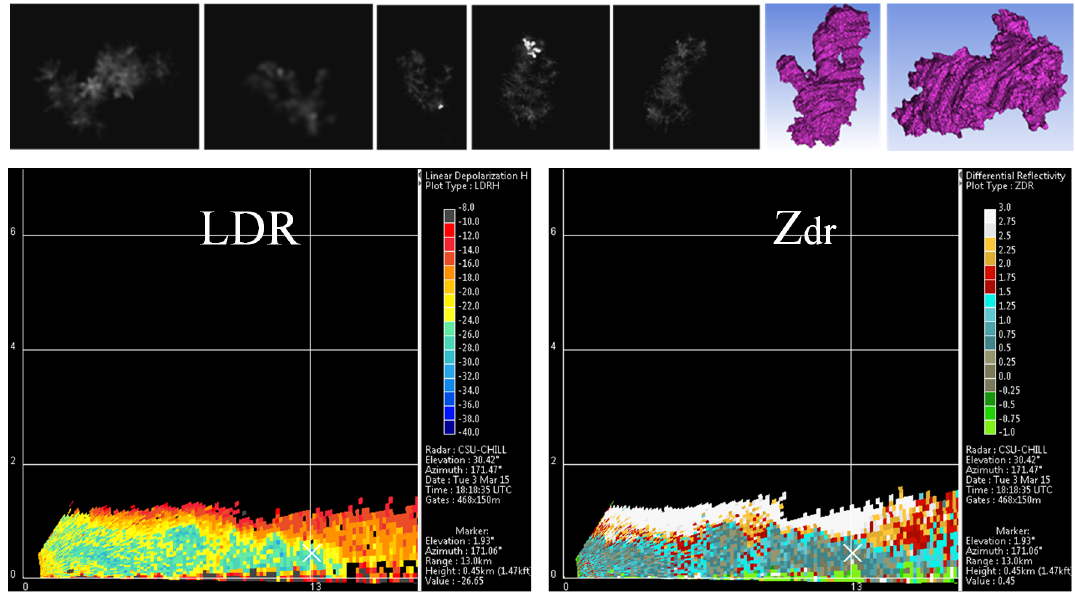
Figure 37. Illustrative results of MoM-SIE scattering calculations based on the MASC images captured at the MASCRAD Field Site during the positive Z dr in dissipating light snow area event on 3 March 2015 and the resulting 3D shape reconstruction, in comparison with the corresponding LDR and Z dr data observed simultaneously by the CSU-CHILL radar. Results: MASC/MoM-SIE: ε r = 1.153 − j0.0002, LDR = − 36 dB, Z dr = 0.28 dB; CHILL Radar: LDR = (cid:1) 27 dB, Z dr = 0.45 dB, at the 12.92-km range.